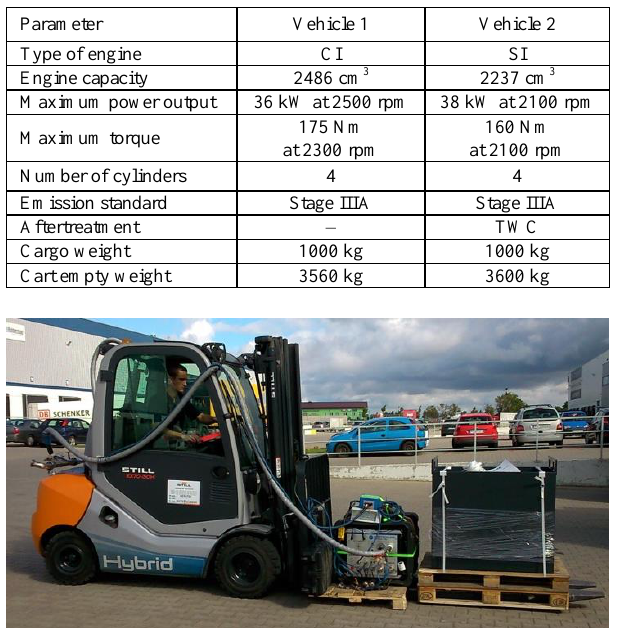
Table 1. Specification of research objects